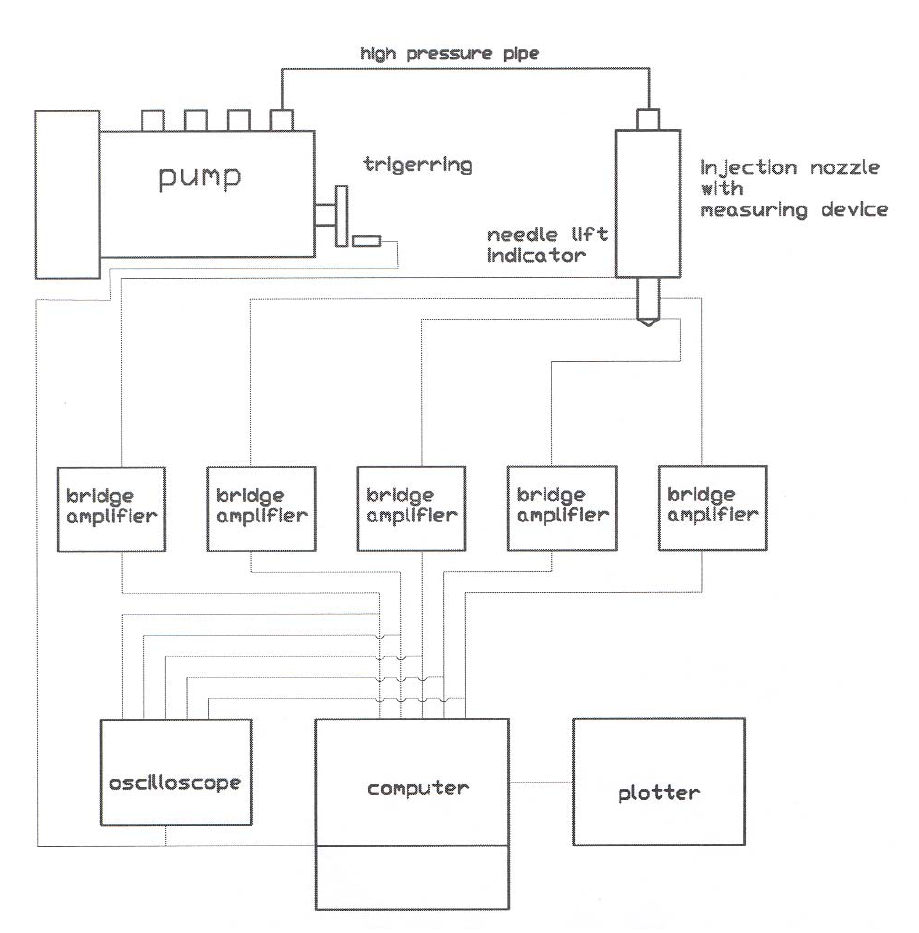
Figure 9. Measuring